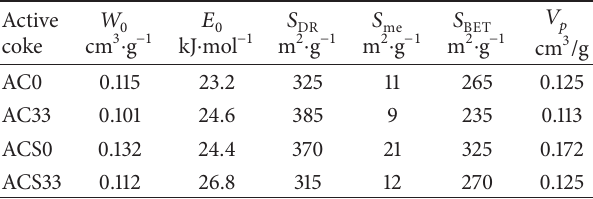
Table 3: Analysis of pore structure and surface area of active